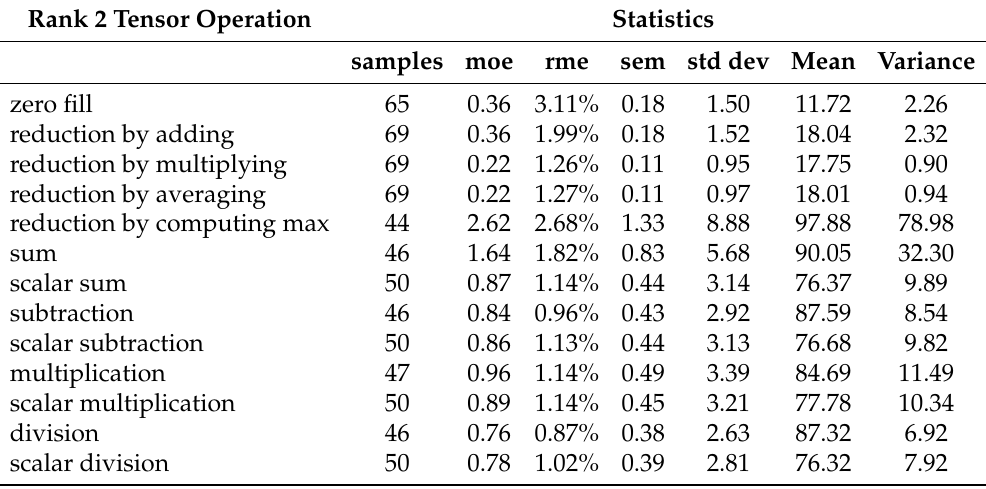
Table 21. Raspberry Pi IV benchmark statistics for rank 2 tensor operations with k = 64 (times in ms).